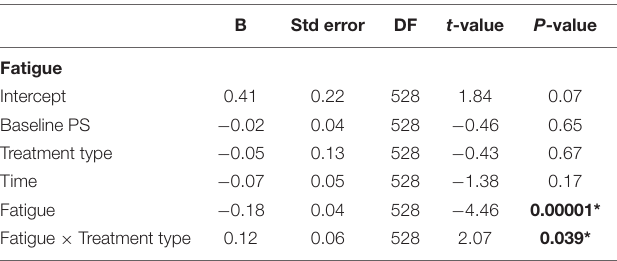
TABLE 3 | A regression model of the MOXO-CPT PS scores in the presence of cognitive